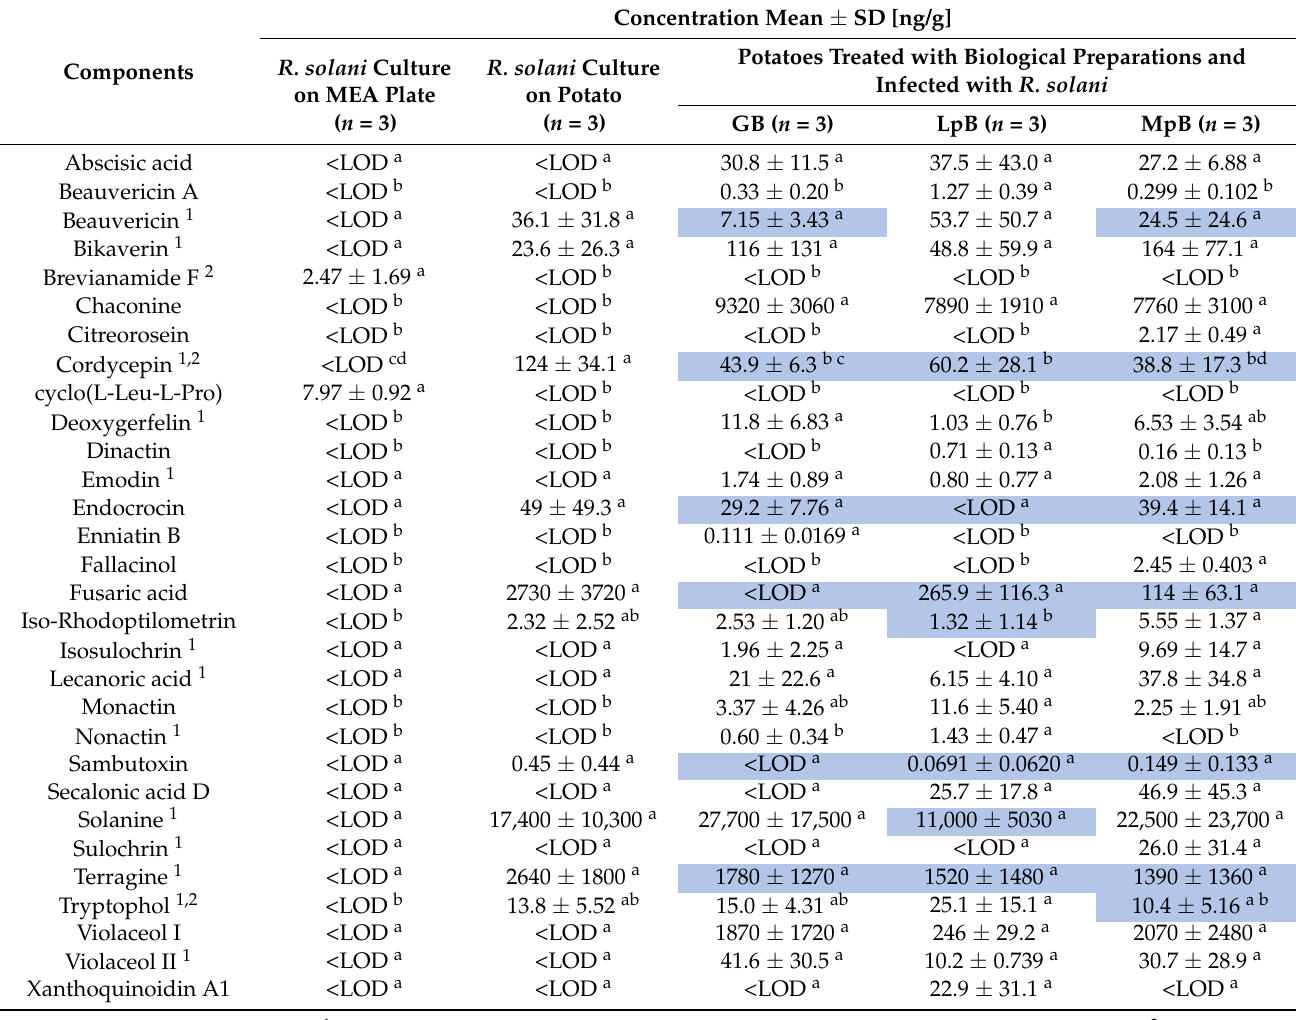
Table 3. Secondary metabolites of Rhizoctonia solani growing on MEA plates and potatoes treated with